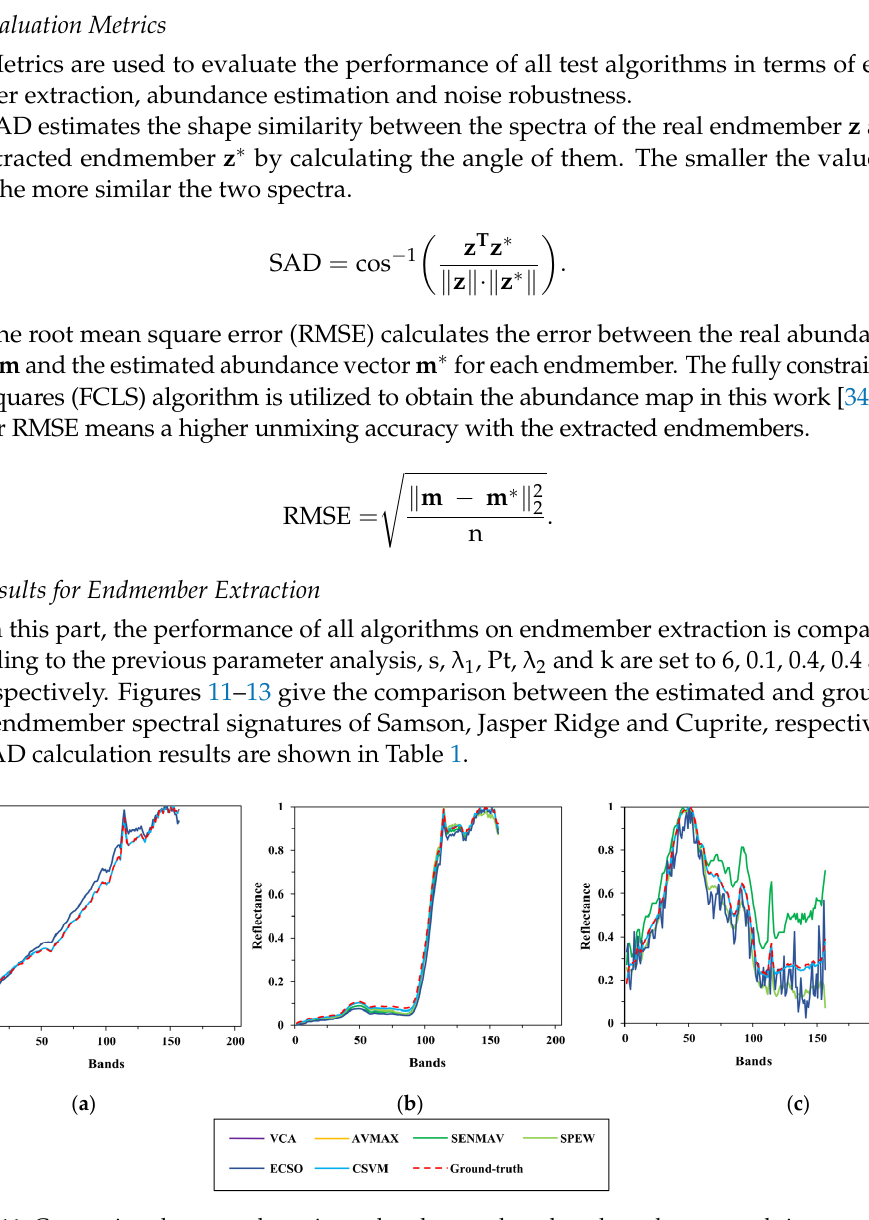
Figure 11. Comparison between the estimated and ground-truth endmember spectral signatures on Samson. ( a ) Soil; ( b ) tree; ( c ) water.